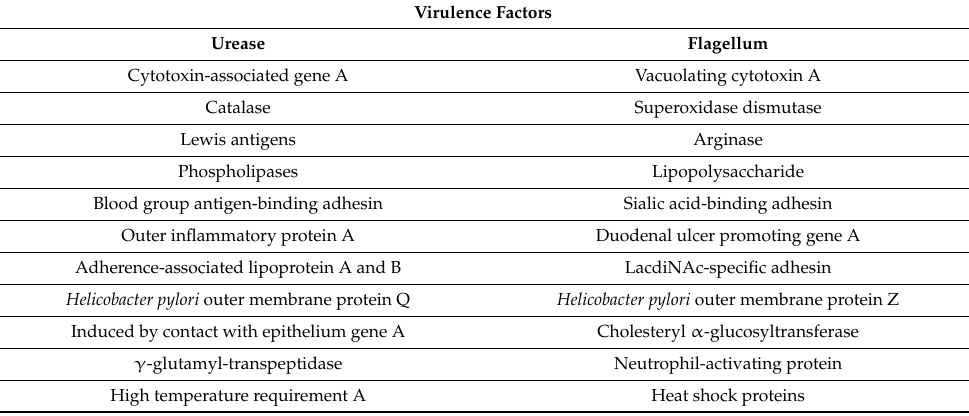
Helicobacter pylori virulence factors that facilitate bacterial survival, colonization, and